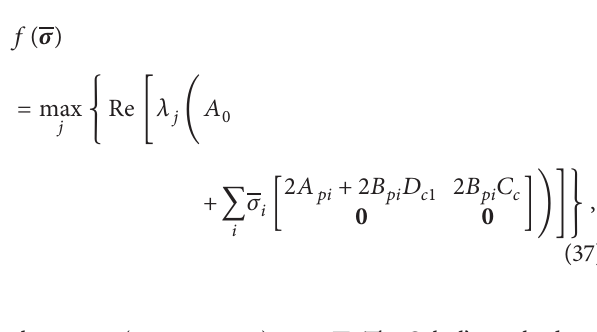
Figure 3: Nominal trajectory of the